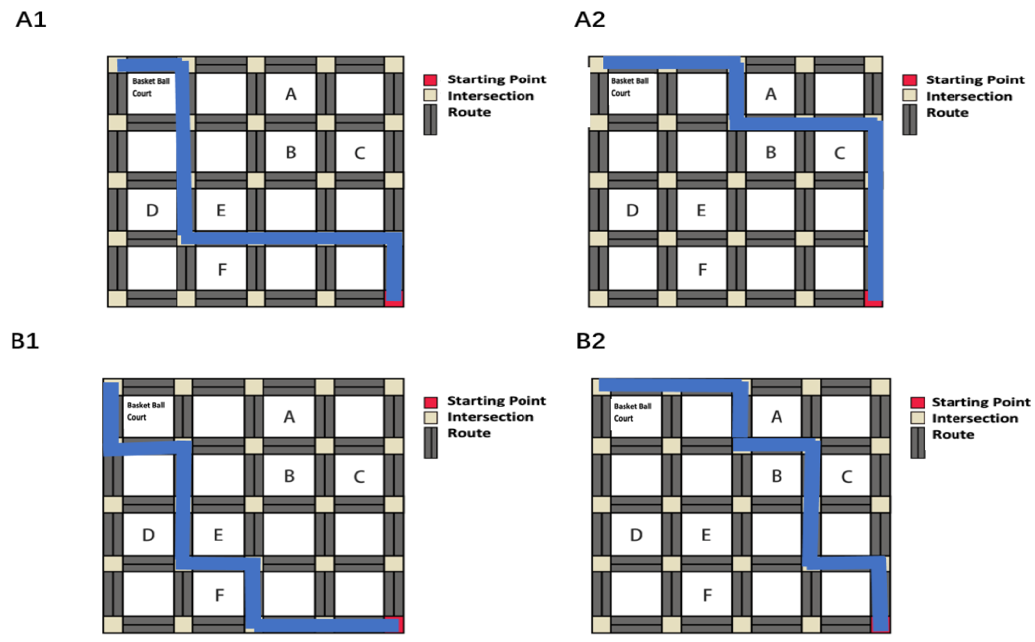
Figure 3. Upper views of easy and difficult routes. ( A1 , A2 ): easy routes with the same difficulty level, ( B1 , B2 ): difficult routes with the same difficulty level.